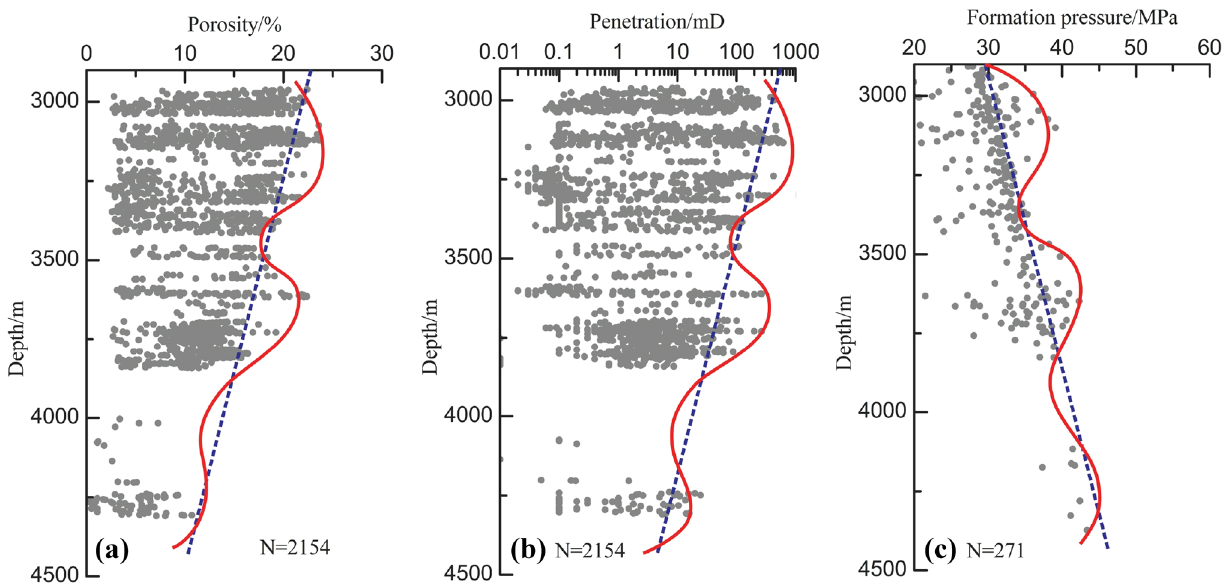
Fig. 5 Distribution of reservoir physical properties and formation pressure in the Dawangzhuang area of the Raoyang